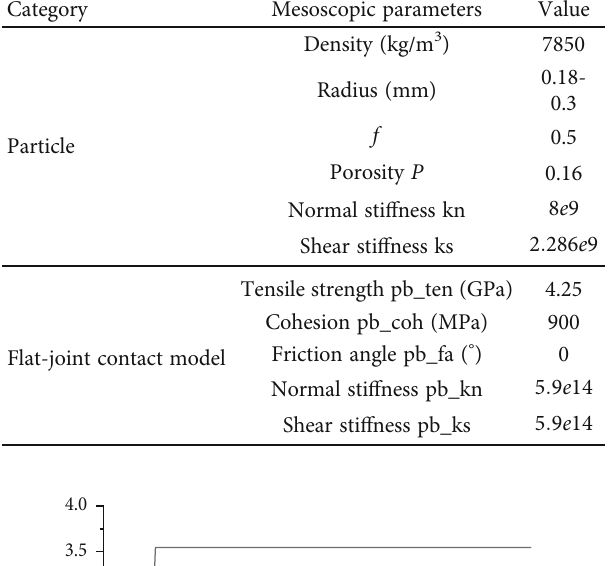
m and macroscopic shear sti